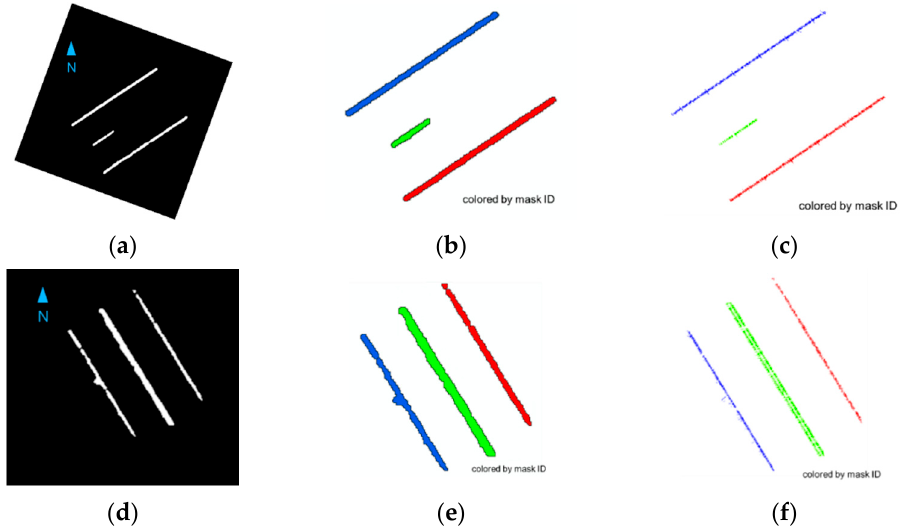
Figure 15. Illustrations of ( a ) predicted image, ( b ) 2D masks, and ( c ) derived 3D lane marking segments in two-lane highways with a dashed line at the center; ( d ) predicted image; ( e ) 2D masks; ( f ) derived 3D lane marking segments in one-lane highways with dual line at the center.